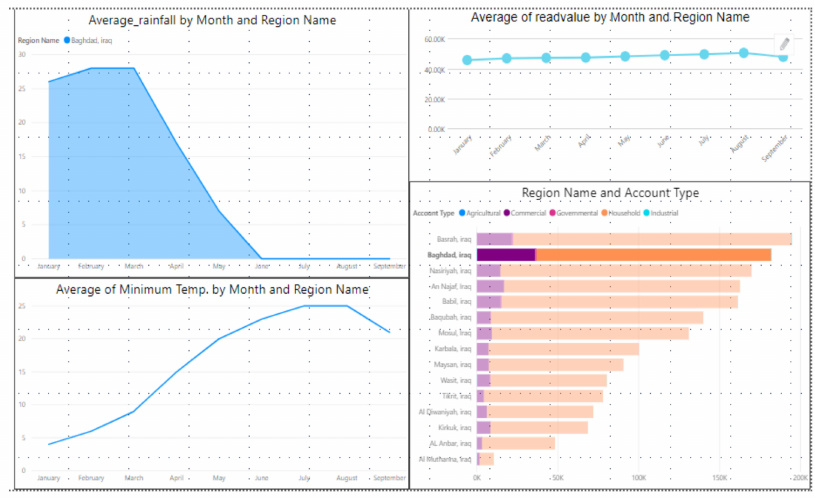
Figure 10. Dynamic Analysis of The City of